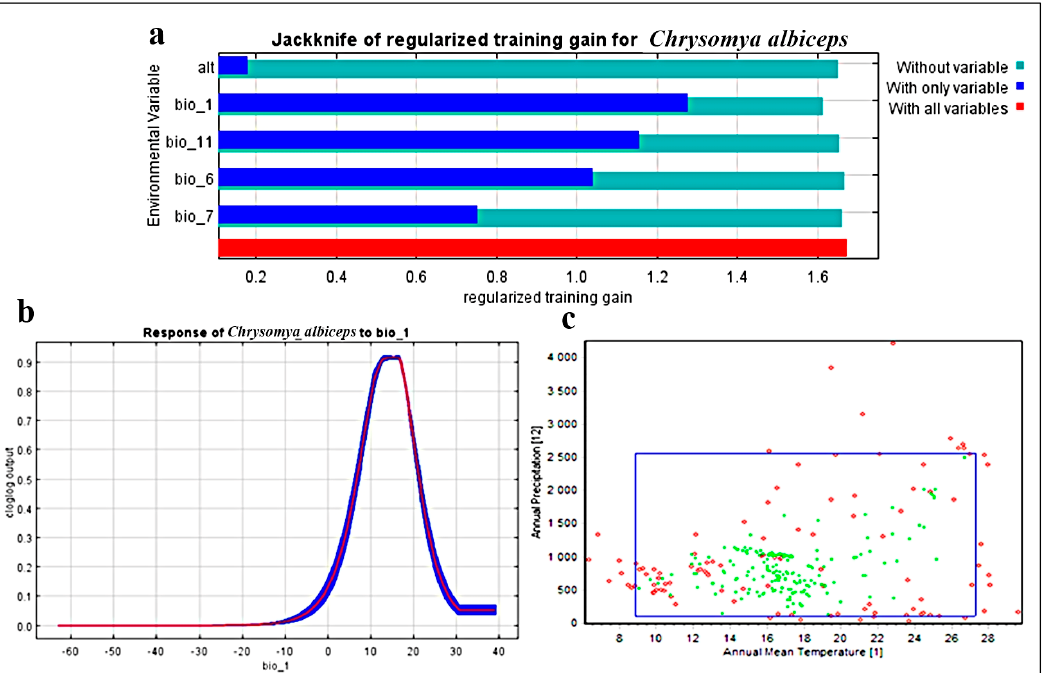
Figure 2. ( a ) The jackknife test of the most important variables, ( b ) Response curve of the most effective bioclimatic factor (bio 1) in C. albiceps distribution, and ( c ) Two-dimensional niche of C. albiceps between annual temperature (bio 1) represented by red dots and annual precipitation (bio 12) represented by green